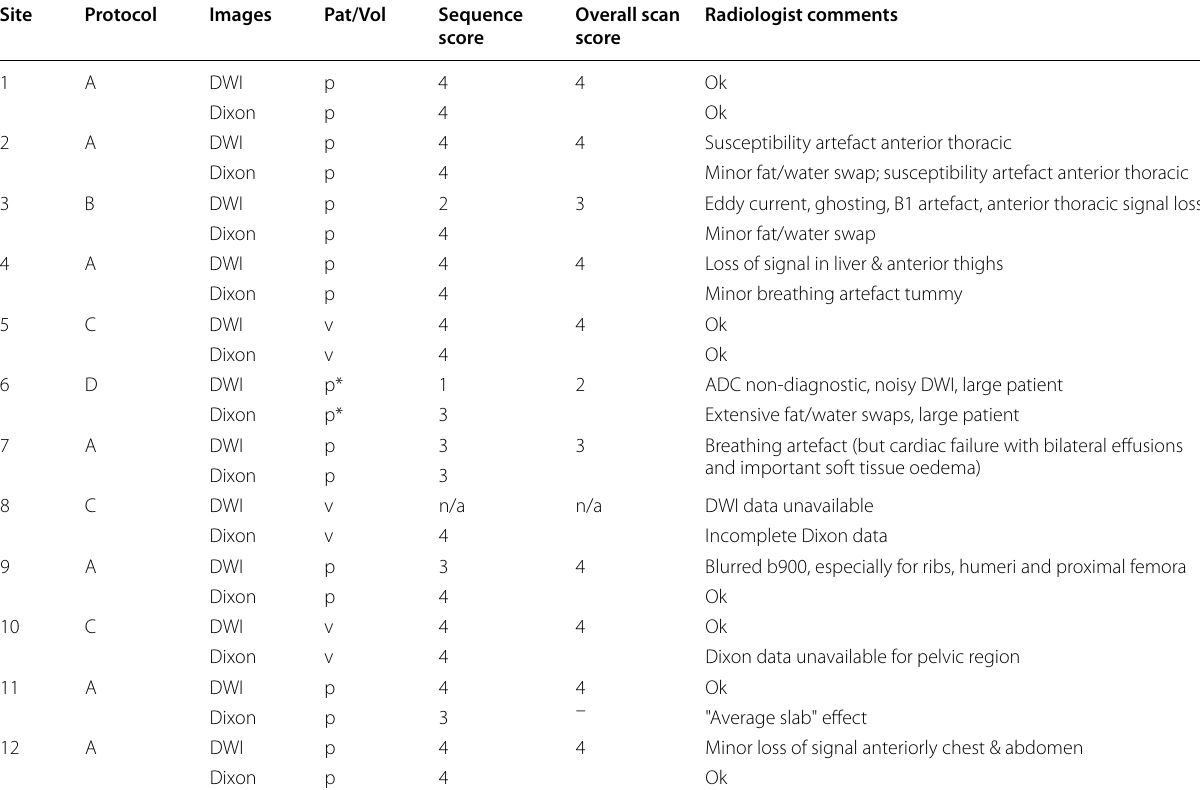
Table 4 Radiological assessment of image quality of initial data (patient or volunteer) from each centre